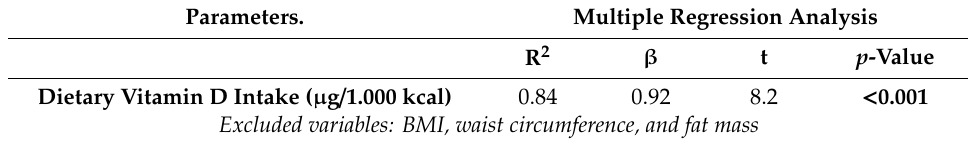
Table 3. Multiple regression analysis models (stepwise method) with 25OHD levels as the dependent variable to estimate the predictive values of BMI, waist circumference, fat mass, and dietary vitamin D intake.